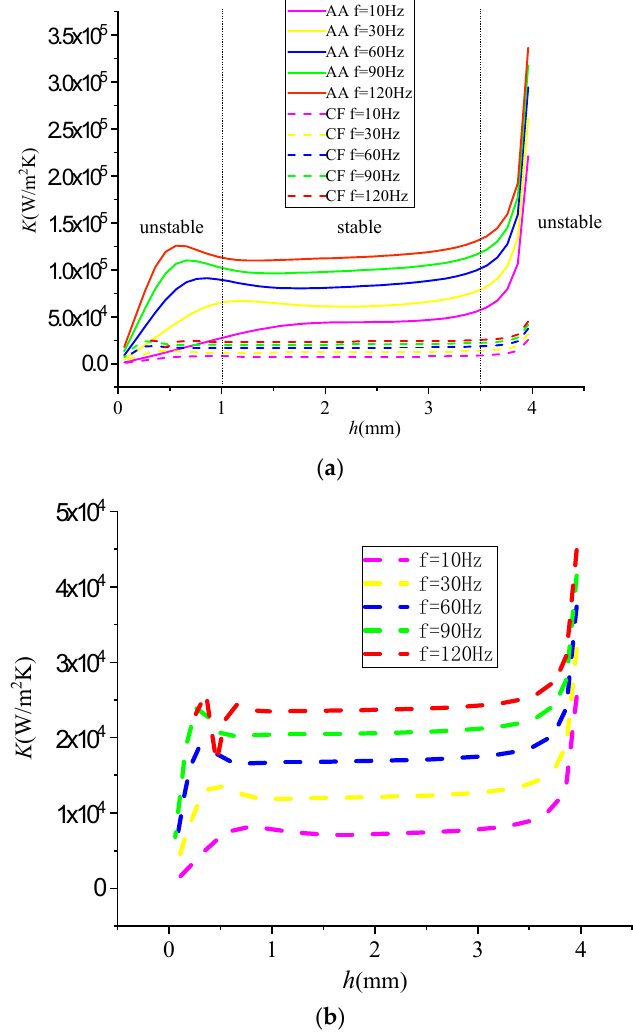
Figure 10. Variation in heat transfer coefficient K with tube wall thickness h. ( a ) Aluminum alloy and carbon fiber ( b ) Enlarged view of carbon fiber.